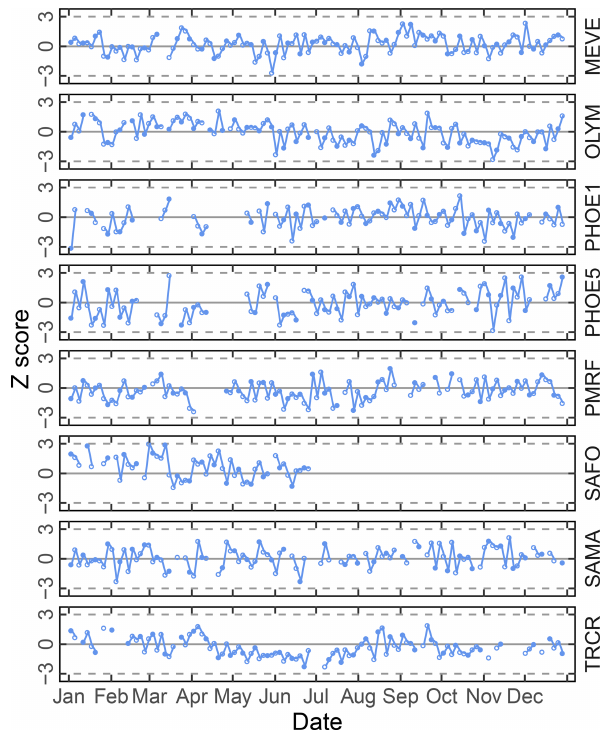
Figure 6. Time series chart of TOR-equivalent OC residuals (for calibration samples) and prediction errors (for test set samples) sep- arated by site. Each value (residual: open circle; prediction error: filled circle) is mapped to a median-centered inverse hyperbolic sine function using 175 values (approximately 20% of the 2011 IMPROVE set) from neighboring TOR OC concentrations to de- rive distribution parameters so that values are defined within a nor- mal distribution ( p value > 0.2). Dotted horizontal lines indicate ± 3 standard deviations of the standard normal variate ( Z